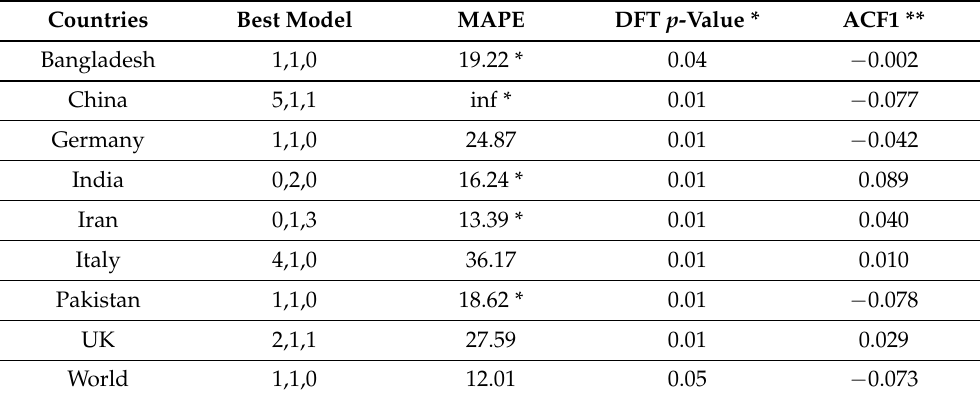
Table 7. Test results of the best models for death